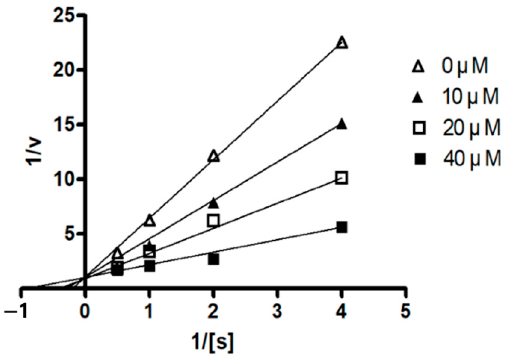
Figure 5. Lineweaver–Burk plots for the inhibition of PTP1B by 1 . The data describe the mean values of three experiments.